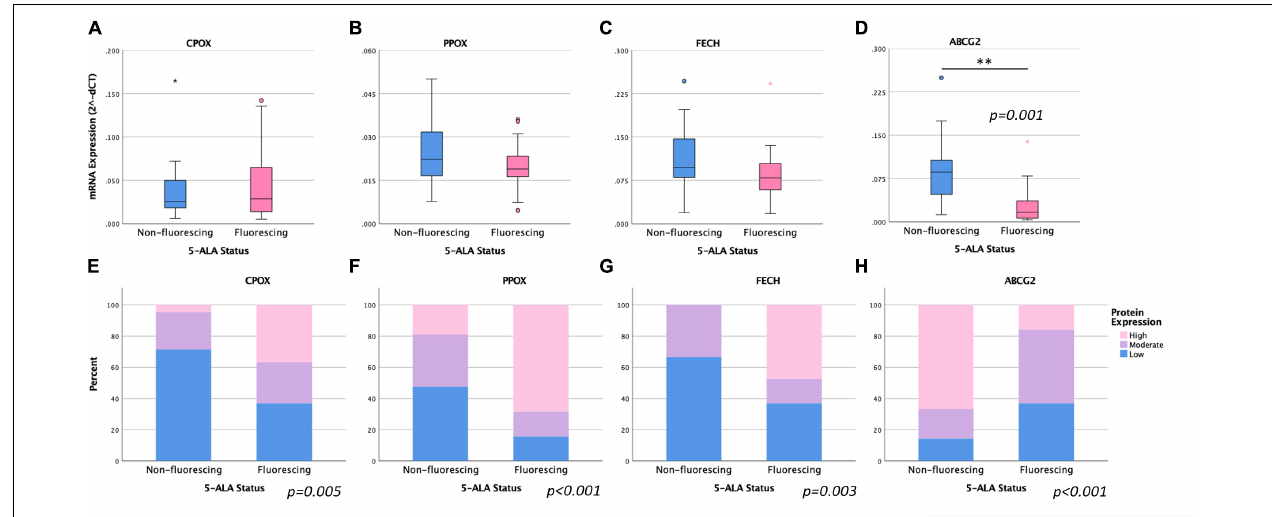
FIGURE 2 | Comparison of mRNA and protein expression of intramitochondrial heme biosynthesis factors between tumor samples with visible 5-ALA fluorescence and absence of fluorescence. (A–D) : Boxplot diagrams are shown for the mRNA levels of CPOX (A) , PPOX (B) , FECH (C) and ABCG2 (D) . (E–H) : Bar Chart diagrams demonstrate the corresponding protein expression levels observed for CPOX (E) , PPOX (F) , FECH (G) , and ABCG2 (H) . For analyses that showed a significant difference between both groups, the respective p -values are included.